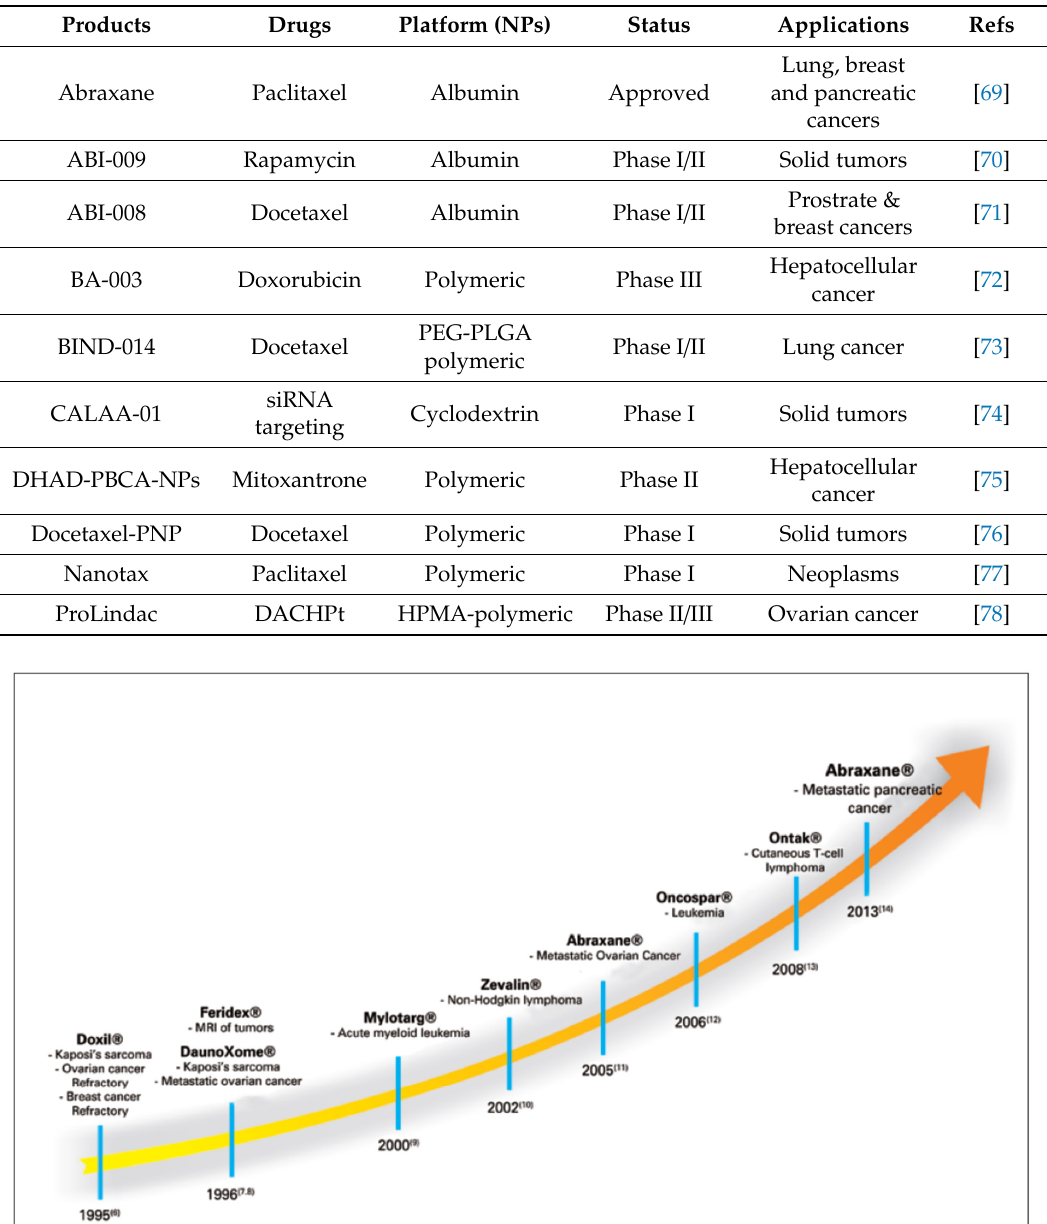
Table 2. The polymer NP-based drugs in clinical trials.